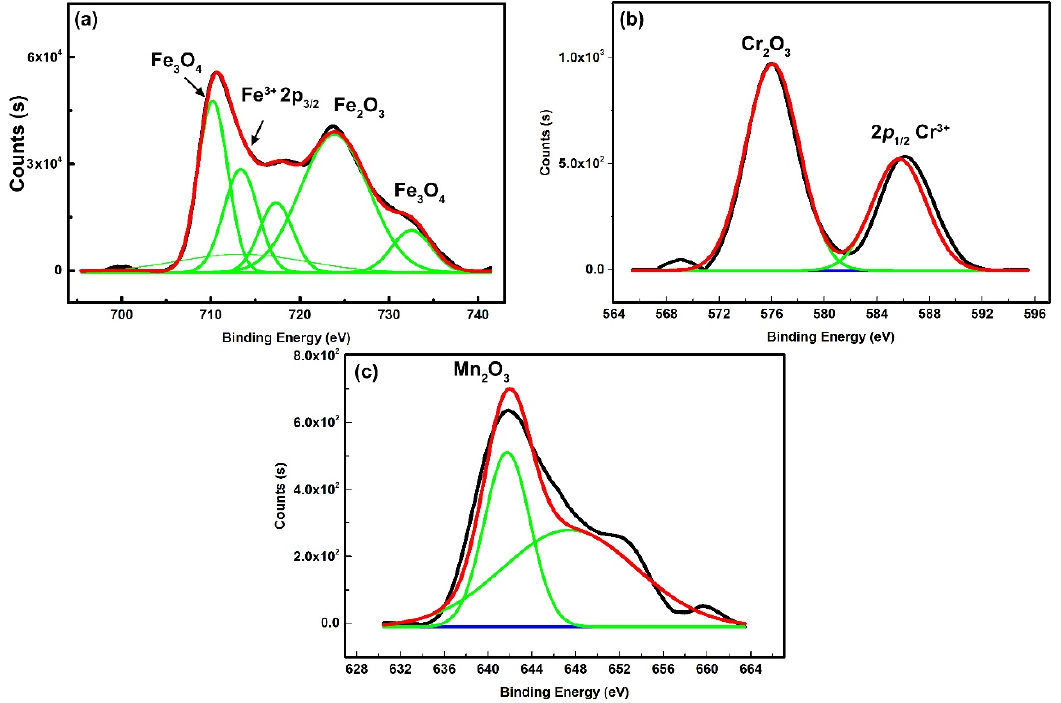
Figure 9. High-resolution XPS spectra obtained on the wear tracks of AM-Inconel 625 after fretting